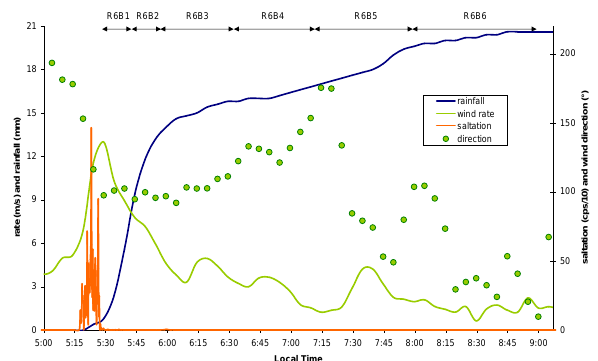
Fig. 2. Surface typical features of the propagating MCS in the case Figure 2 : Surface typical features of the propagating MCS in the case of the rain R6 (14/07/2006): At of the rain R6 (14 July 2006): at the leading edge of the MCS, down- the leading edge of the MCS, downdraughts from the convective cells produce an increasing of draughts from the convective cells produce an increasing of surface surface wind and hence a high wind erosion with important dust emission, then to the rear of the MCS wind and hence a high wind erosion with important dust emission, front, severe rain occurs, inhibiting dust atmospheric charge. Here, the different successive time of then to the rear of the MCS front, severe rain occurs, inhibiting dust rainwater sampling are represented for the rain R6 (R6B1 to R6B6). atmospheric charge. Here, the different successive time of rainwater sampling are represented for the rain R6 (R6B1 to R6B6).